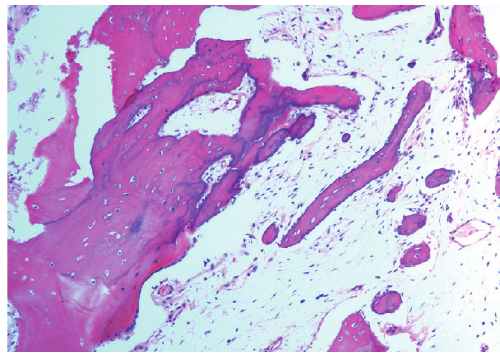
Figure 4: Photomicrograph showing woven bone with numerous basophilic reversal lines with fibrous stroma, while some areas con- tained peculiar woven bone without fibrous stroma. (magnification ×